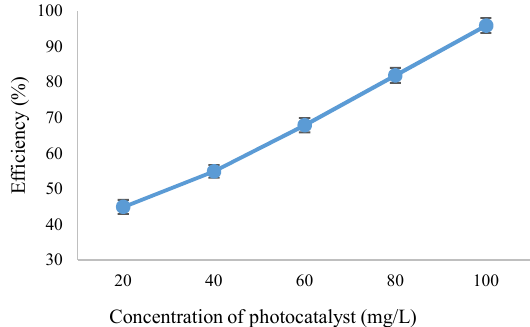
Concentration of photocatalyst Fig. 6. Effects of photocatalytic concentration changes on removal of acid blue 113 dye (pH: 3, initial dye concentration: 100 mg/l, modified photocatalyst concentration: 100 mg/l, reaction time: 30 minutes)